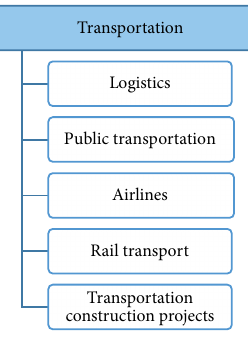
Fig. 4. Research domains in Transportation Table 2. MCDM applications by research domains in Transportation research area Research domain and the problem